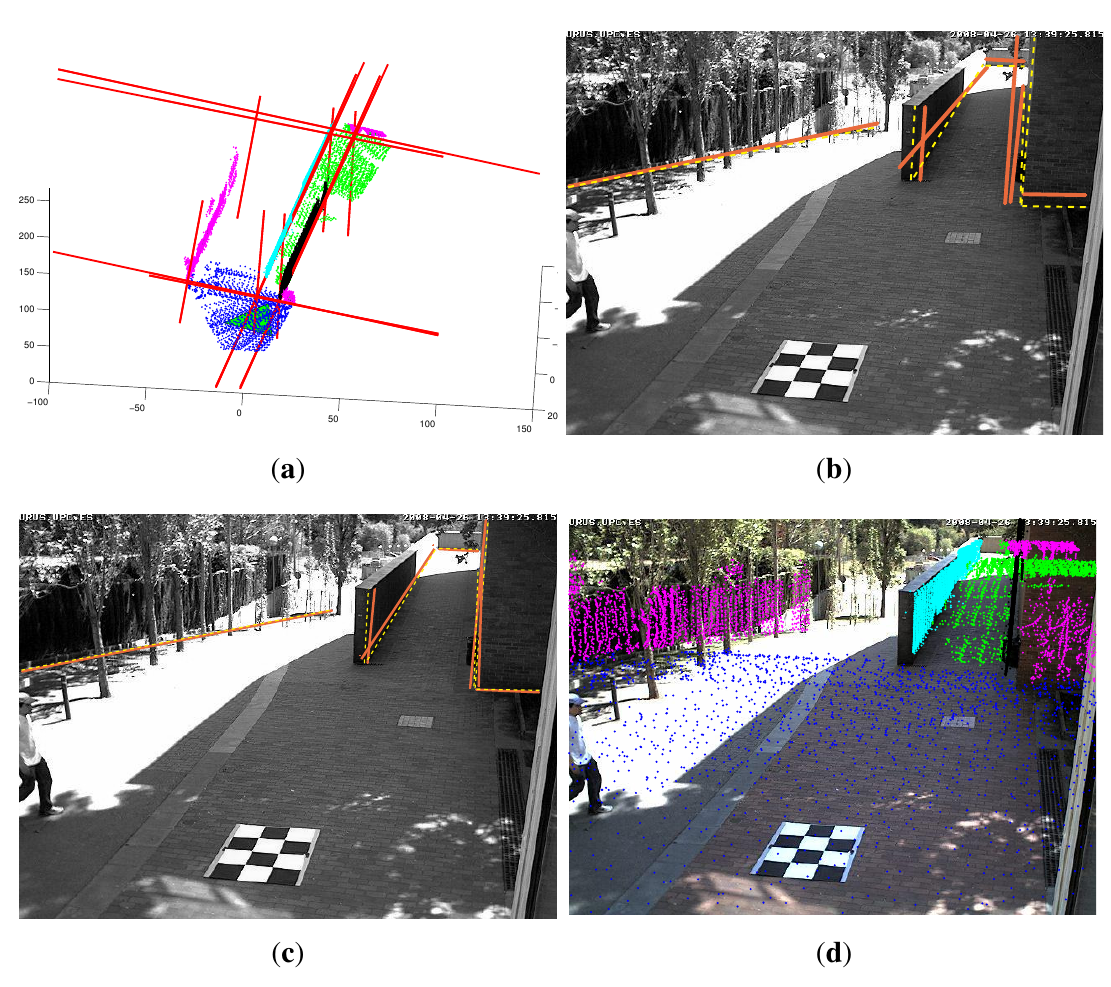
( a ) Computation of plane intersections in the range